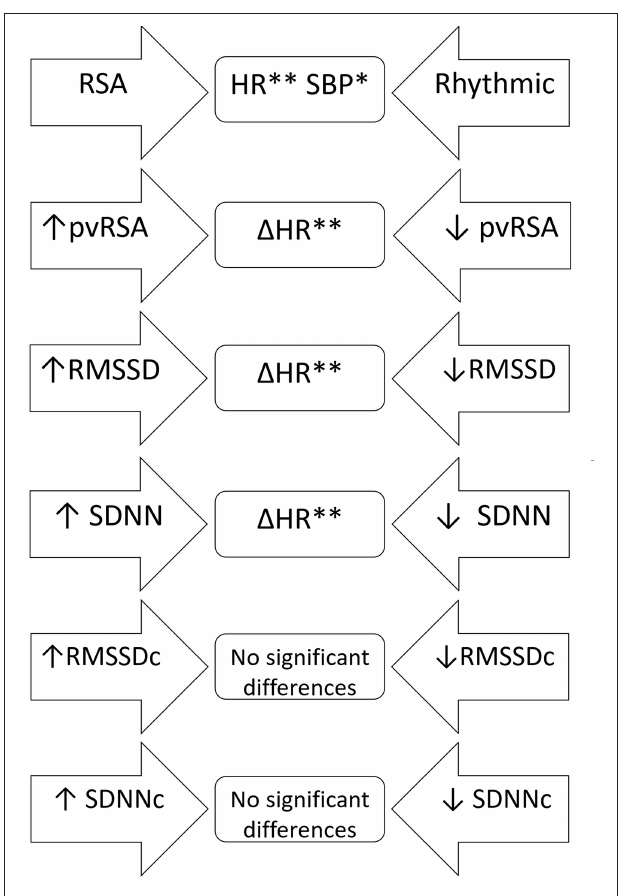
FIGURE 4 | A scheme of comparative analysis of independent samples regarding anthropometric and laboratory variables as well as their changes across time in relation to the trajectory of various RSA indices. The arrow-shaped fields represent compared subgroups; variables, for whom the differences were statistically significant were listed in the middle part. RSA, students with respiratory sinus arrhythmia at both visits; Rhythmic, students with rhythmic heart rate on both electrocardiograms; ↑ , increase in a distinct variable across time; ↓ , decrease in a distinct variable across time; 1 , change of the parameter throughout the observation period. * p < 0.05; ** p < 0.001.